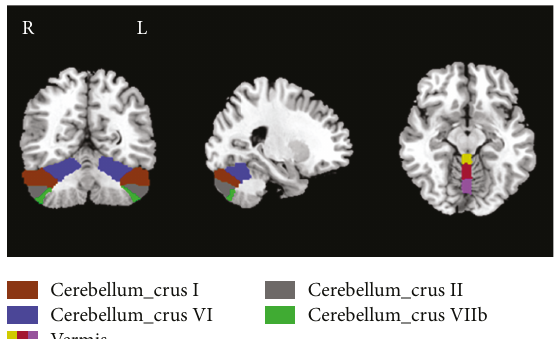
Figure 2: Nine subregions of the cerebellum including bilateral crura I (brown), II (grey), VI (indigo), and VIIb (green) and vermis (yellow/red/lavender). R: right hemisphere; L: left hemisphere. Slices shown for X = 27 mm , Y =-52mm, and Z